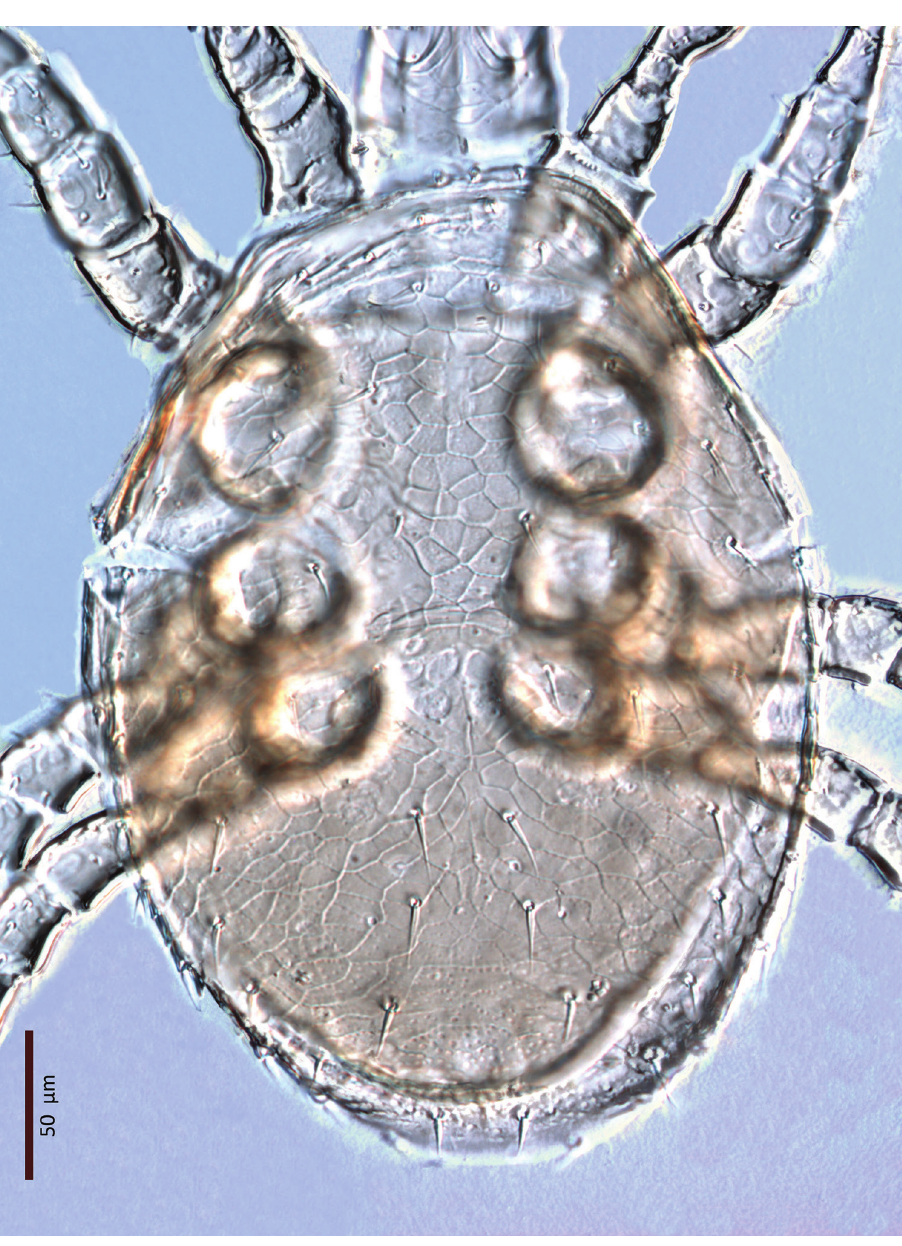
In his diagnosis of the genus Zygoseius , Halliday (1997) indicated one pv and one pl setae on trochanter IV, whereas Evans (1963a) indicated two pv and no pl (as we did, herein). Indeed, pv1 is inserted much more posteriorly than pv2 (although